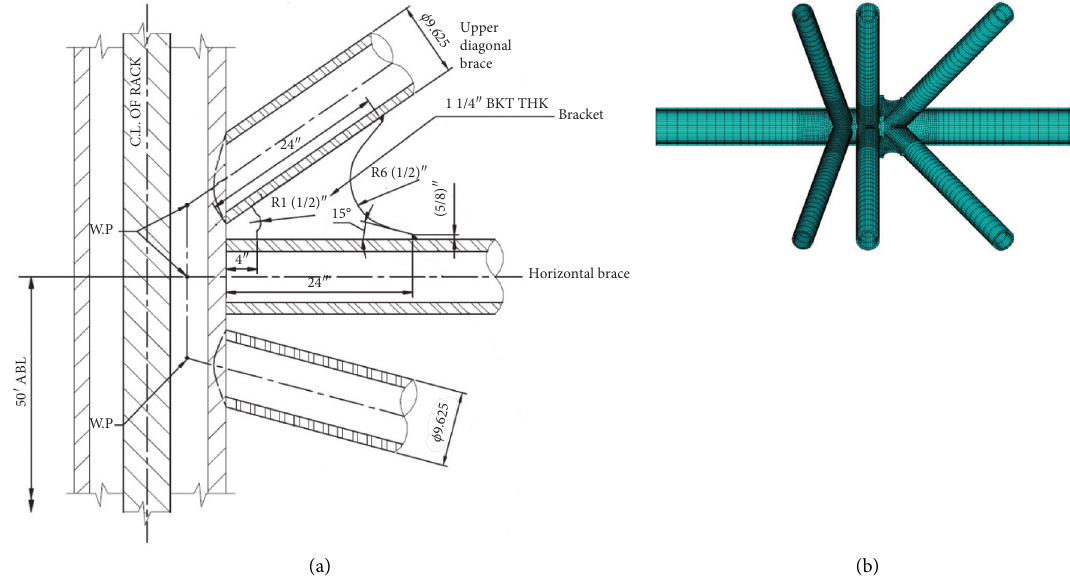
Figure 3: A bracket-stiffened two-planar overlapped KT-joint: (a) design drawing and (b) finite element